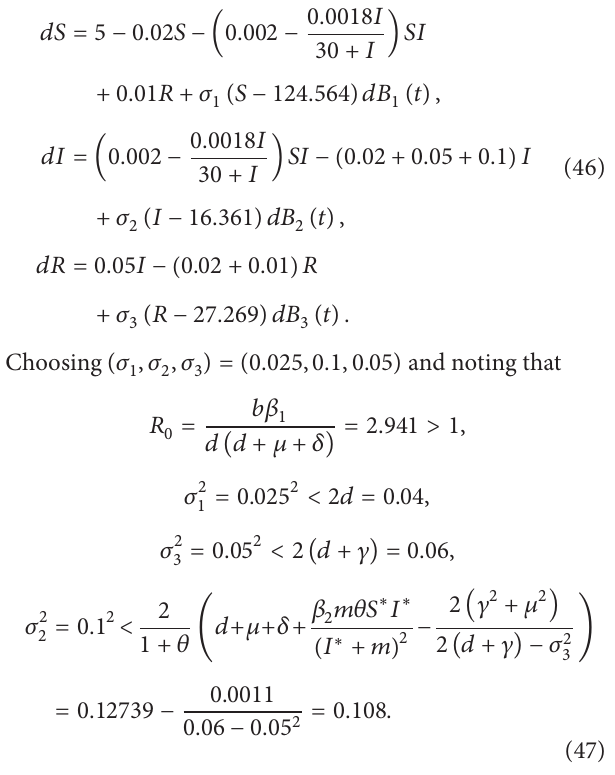
The parameters of model (8) are fixed as (20). Then model (8) has the endemic point 𝐸 ∗ = (124.564, 16.361, 27.269) . And model (8)